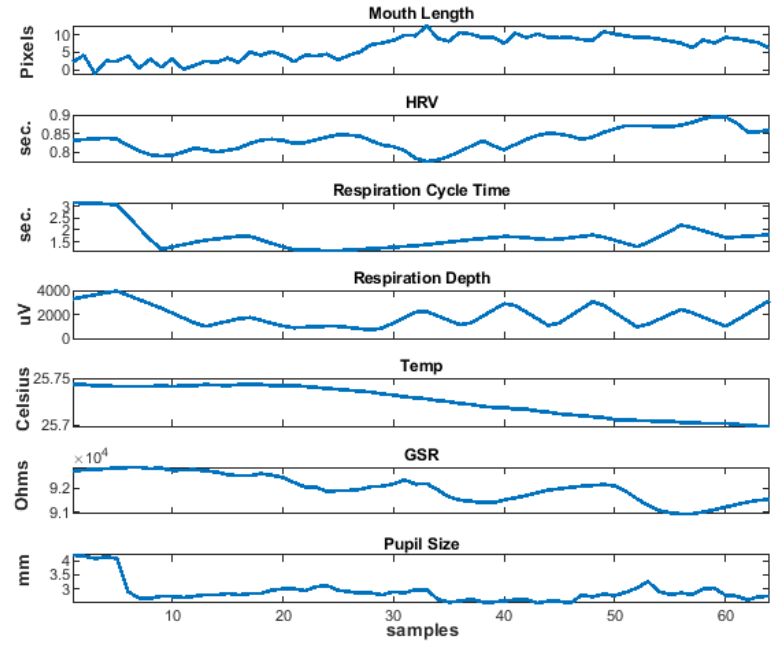
Figure 4. Elicited signal features in the last 30 seconds of video.